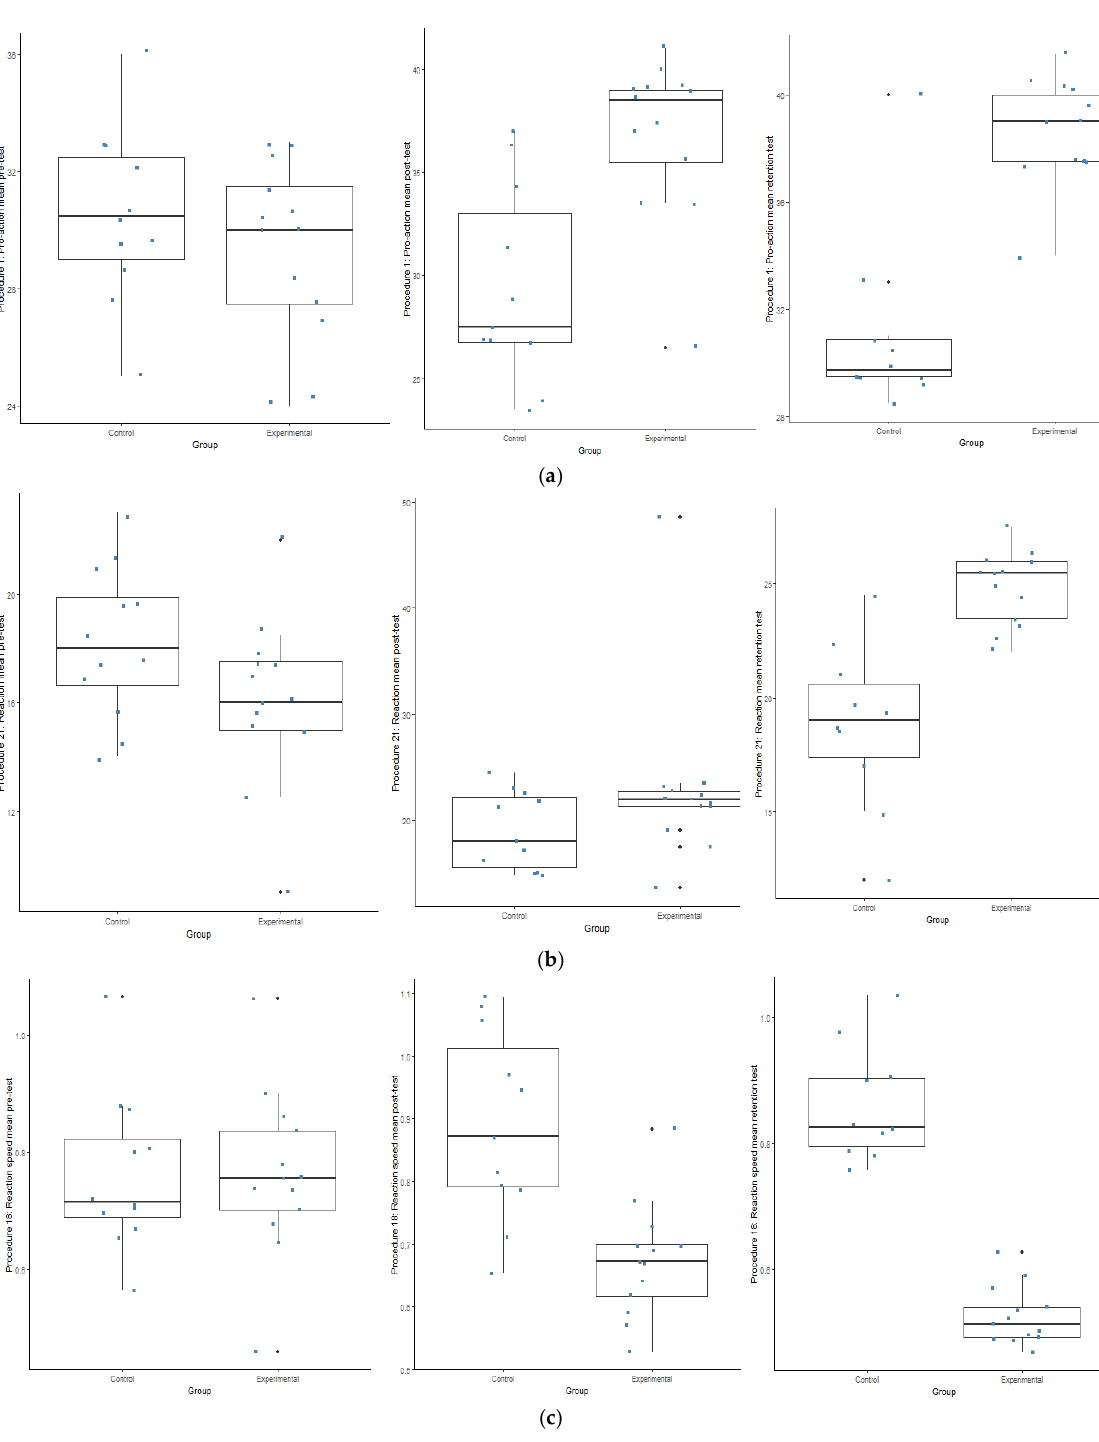
Figure 4. ( a – c ) Box plots indication the interaction within the control and experimental groups during the Wayne Saccadic Fixator (WSF) test. ( a ) Box plots indicating the interaction within the groups during the pre-; post and retention test during Procedure 1. ( b ) Box plots indicating the interaction within the groups during the pre-; post and retention test during Procedure 21. ( c ) Box plots indicating the interaction within the groups during the pre-; post and retention test during Procedure